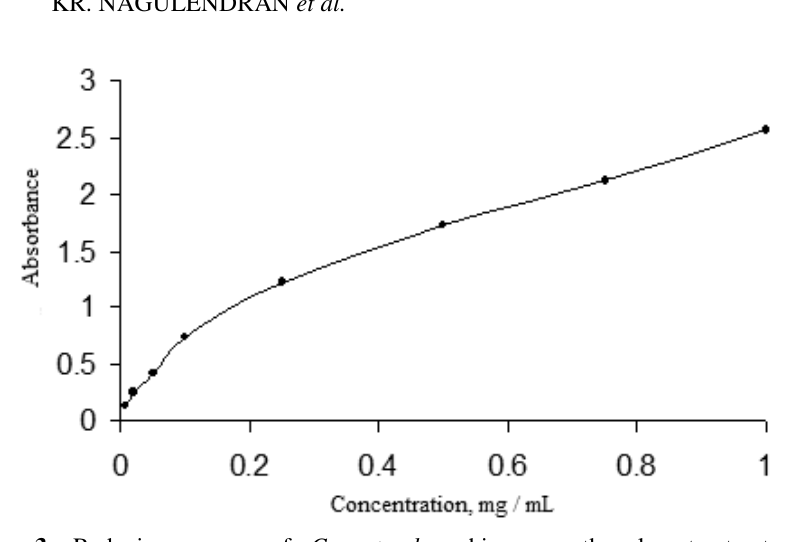
Figure 3. Reducing power of C. rotundus rhizomes ethanol extract at different concentrations. Each value represents means ± SD (n=3). High absorbance at 700 nm indicates high reducing power.